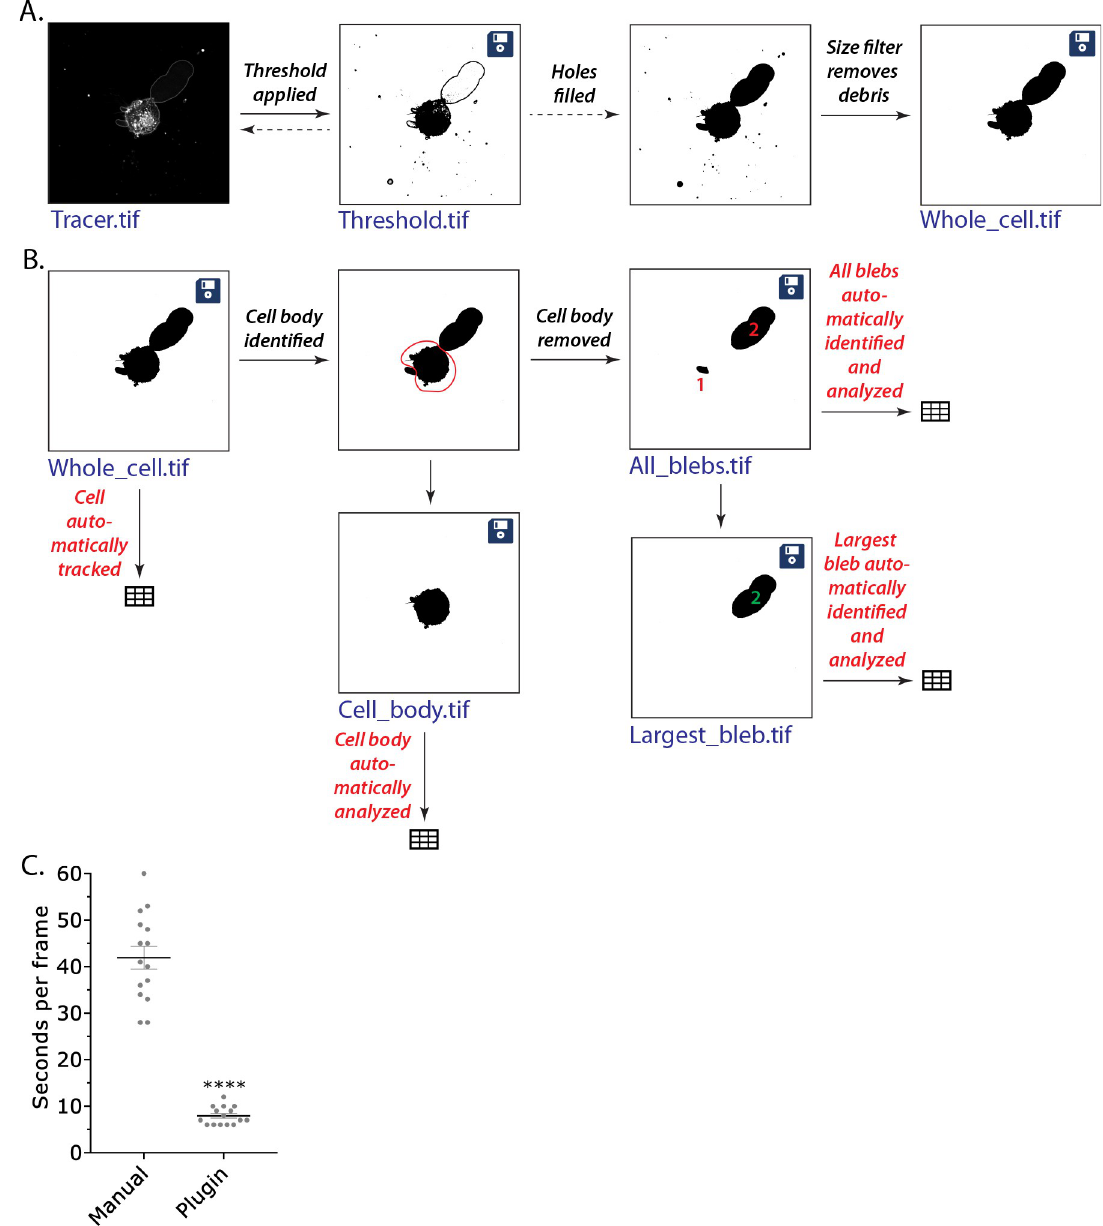
Fig 3. Overview of the Analyze_Blebs plugin. A. Image binarization approach is previewed and selected. The threshold choice can be edited further to fill holes and remove any attached noise. B. Analysis workflow creates a series of binary image stacks with isolated subcellular structures. Whole cell is first isolated with size exclusion, then the cell body is removed by user input, and remaining images are created by the plugin. Disk icon on image indicates that the image series is saved with the name listed in blue. Spreadsheet icon indicates a CSV file was saved for that image analysis under image name. C. For each frame of a time-lapse movie, the amount of time required to manually trace the cell outline vs. the plugin was compared. Error is SEM. Statistical significance was determined using a two-tailed Student’s